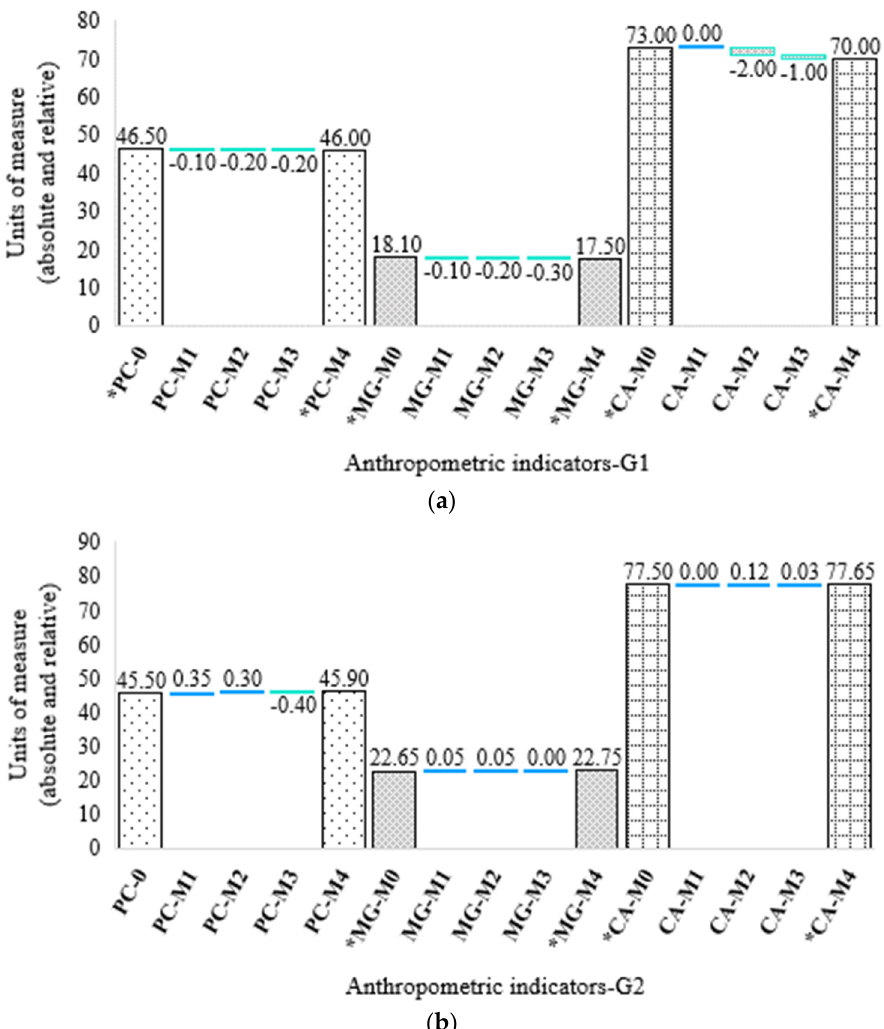
Figure 2. Increases and decreases in anthropometric indicators. ( a ) Treated group (G1); ( b ) Untreated group (G2). The bars with the same texture represent the baseline and final measurement of an evalu- ated indicator; the blue and green lines show the increase or decrease in each indicator throughout the 4 − week period. Body weight (PC); Fat mass (MG); Abdominal circumference (CA); Measurements 0 − 4 (M0 − M4). Absolute measurement units (kilograms and grams for PC and centimeters for CA) and relative values (percentage for MG) are given. * Statistically significant difference according to the Friedman test ( p <